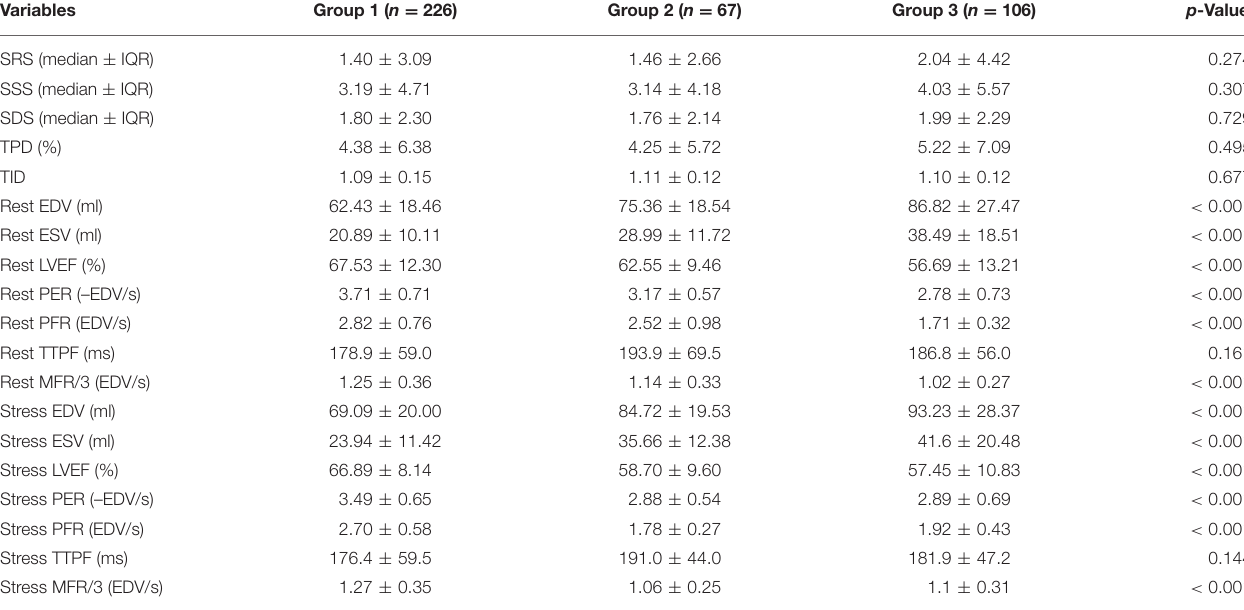
TABLE 2 | D-SPECT data of the study